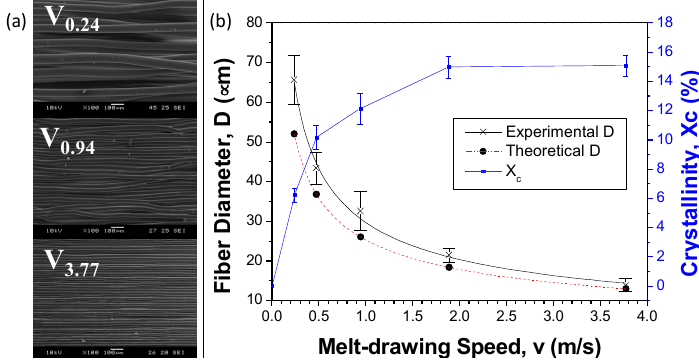
Figure 4. ( a ) SEM images of PLC scaffolds fabricated with different melt-drawing speeds; ( b ) Graphical illustration on the effect of melt-drawing speeds on the fiber diameters from theoretical and experimental. Effect of melt-drawing speeds on the crystallinity of PLC is included in the graph. The fiber diameters of the samples V 0.24 , V 0.47 , V 0.94 , V 1.88 and V 3.77 were 65.7 ± 6.2, 43.5 ± 4.1, 32.6 ± 5.0, 21.5 ± 1.8, and 13.9 ± 1.7 µm, respectively. A model to empirically link the fiber diameter to the